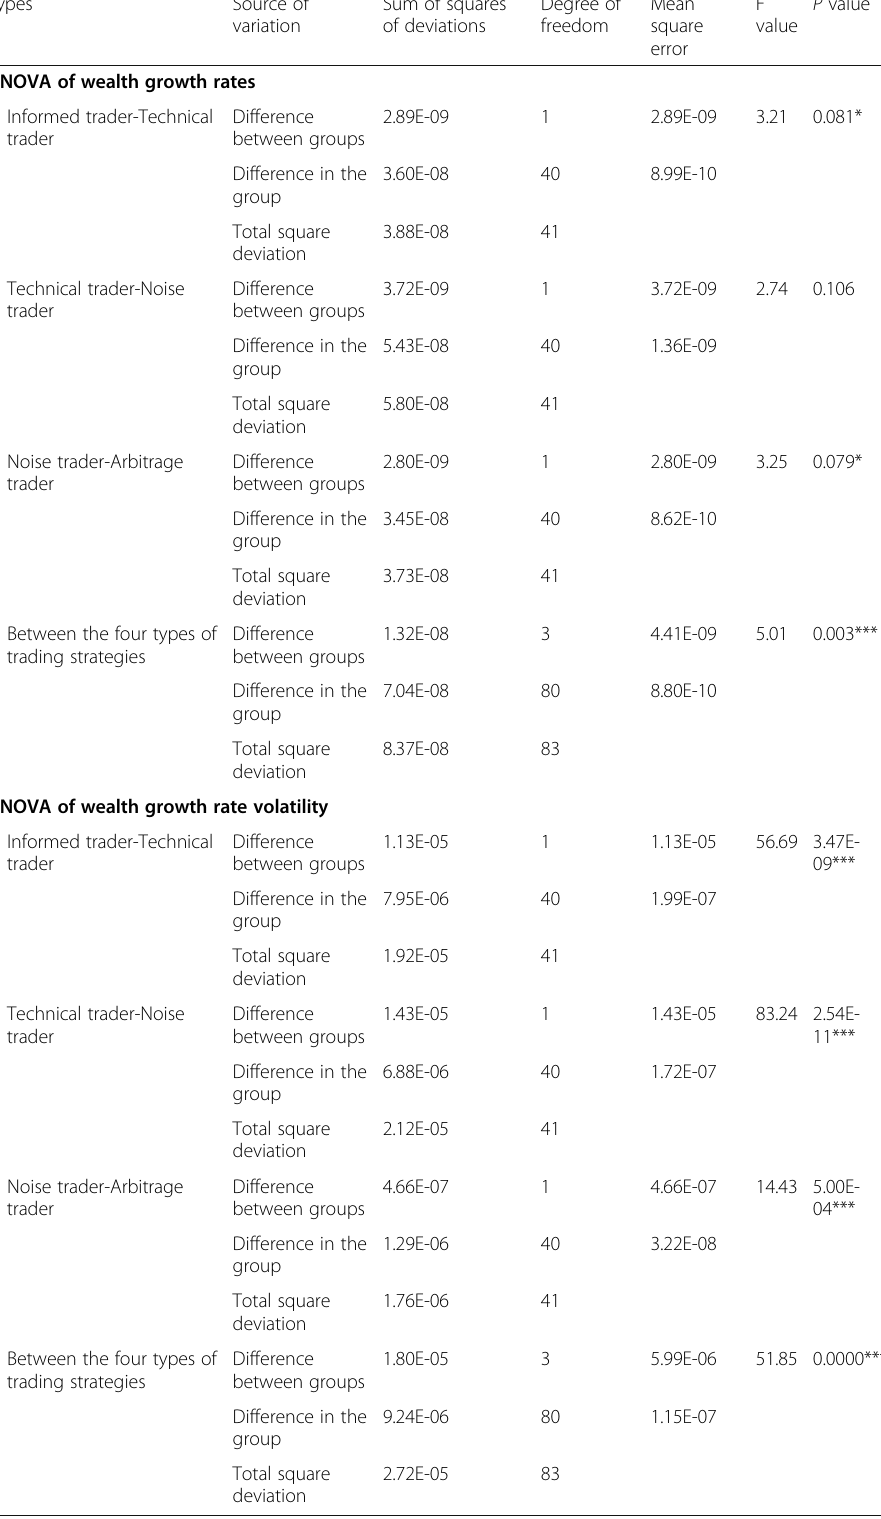
Table 3 ANOVA of wealth growth rates and wealth growth rate volatility